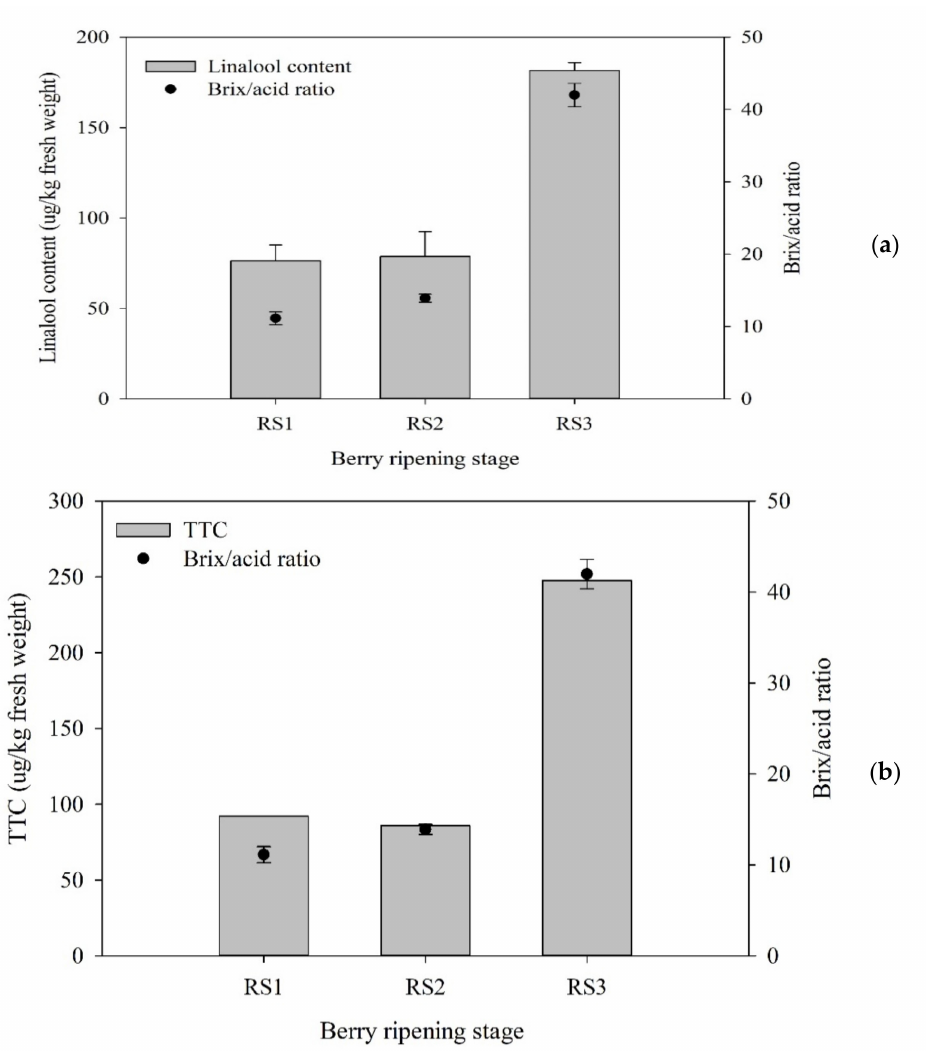
Figure 6. Dual axes bar and scatter overlay plots for ( a ) the monoterpenes content and ◦ Brix / acid ratio and ( b ) the linalool content and ◦ Brix / acid ratio of Shine Muscat grape berry extracts at di ff erent ripening stages: RS1, ripening stage 1; RS2, ripening stage 2; and RS3, ripening stage 3; TTC, total monoterpenes content. The increasing numbers behind the abbreviation RS indicate the degree of ripening. All data represent mean ±